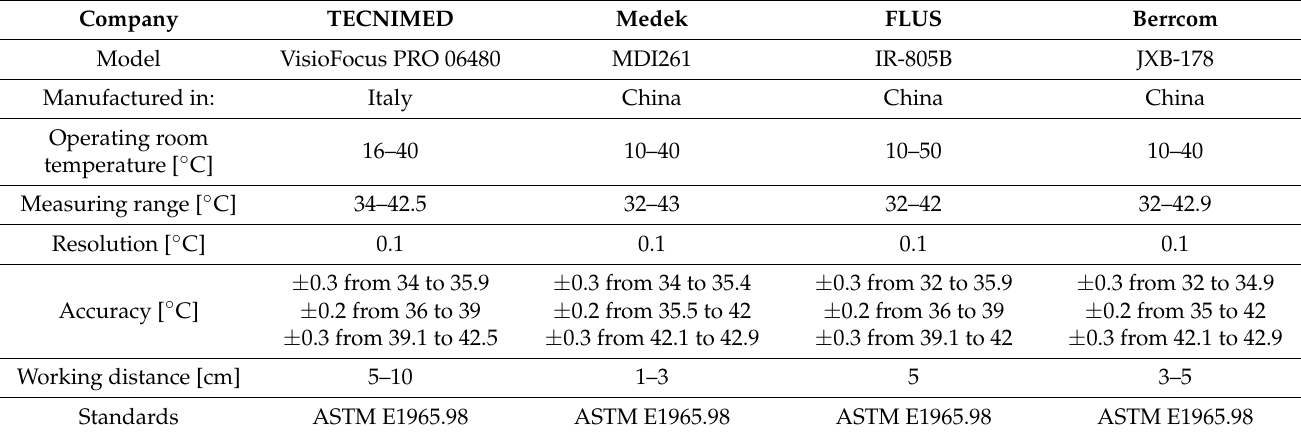
Table 1. Main manufacturer’s technical specifications for the four non-contact infrared point thermometers considered in this